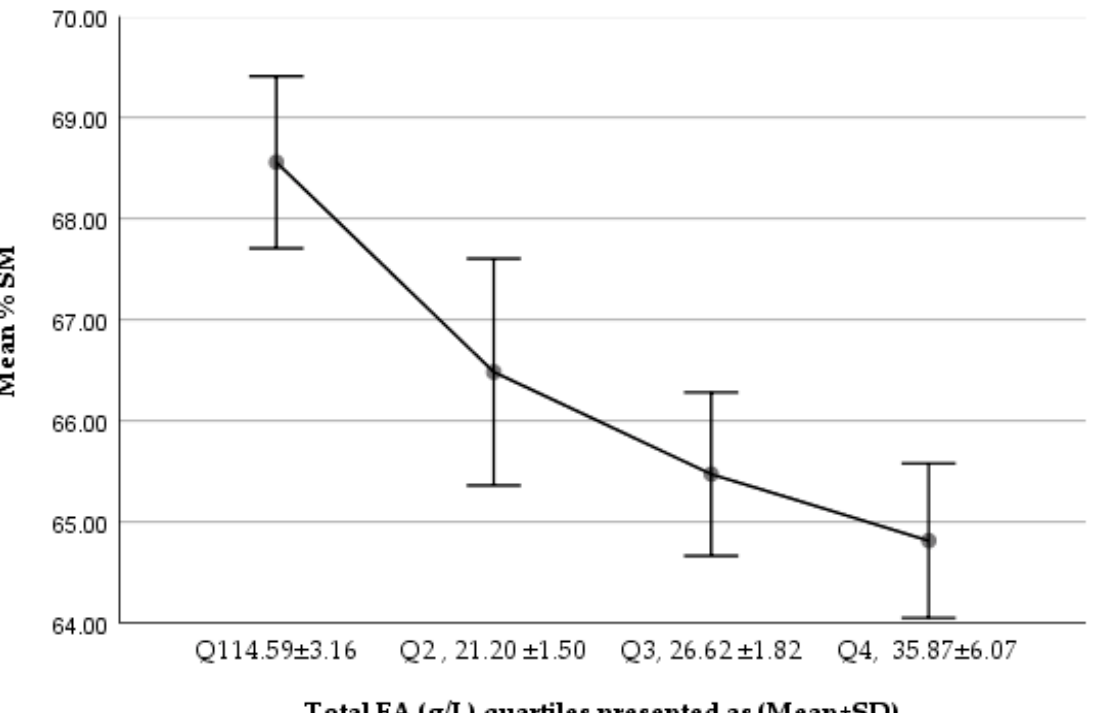
Figure 1. Trend of %PC of total PLs in Q1–Q4 (total FA g/L) of the studied milk samples.